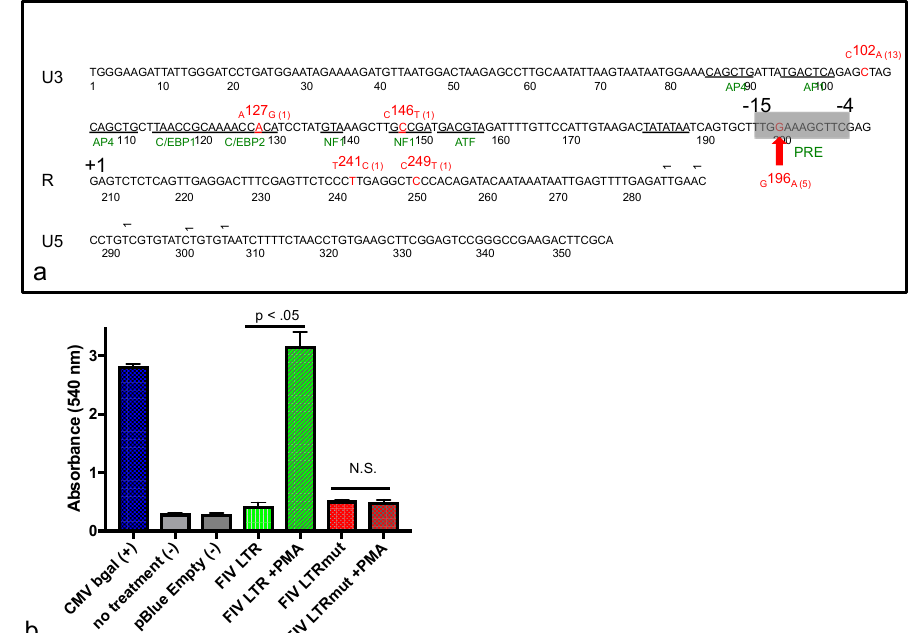
Figure 6. ( a ) The FIV promoter (LTR) sequenced from the tissues of cat 165 has multiple single nucleotide point (SNP) mutations. The U3, R, and U5 regions of the inoculating FIV sequence are depicted in black, while the various SNPs are indicated in red; parentheses indicate the number of times the SNP was isolated out of 14 sequenced clones. Known TFB sites are indicated in green, and the putative phorbol myristate acetate (PMA) Response Element (PRE) is denoted by a shaded grey box (nucleotide position −15 to −4, where +1 is the viral transcription start site, R). The G 196 A SNP is emphasized with a red arrow. ( b ) A β-galactosidase reporter gene assay identifies a novel PMA Response Element in the 3′ aspect of the FIV U3 region. The basal function of the wild type promoter (FIV LTR, green) and FIV promoter with the G 196 A SNP (FIV LTRmut, red) is minimal relative to negative controls (no treatment and pBlue Empty). PMA treatment markedly induces the wild-type FIV promoter expression (FIV LTR + PMA, p < 0.05, green cross-hatch), but has no detectable effect on the FIV promoter with the G 196 A SNP (FIV LTRmut, not significant, red cross-hatch), relative to transfected cells not treated with PMA.